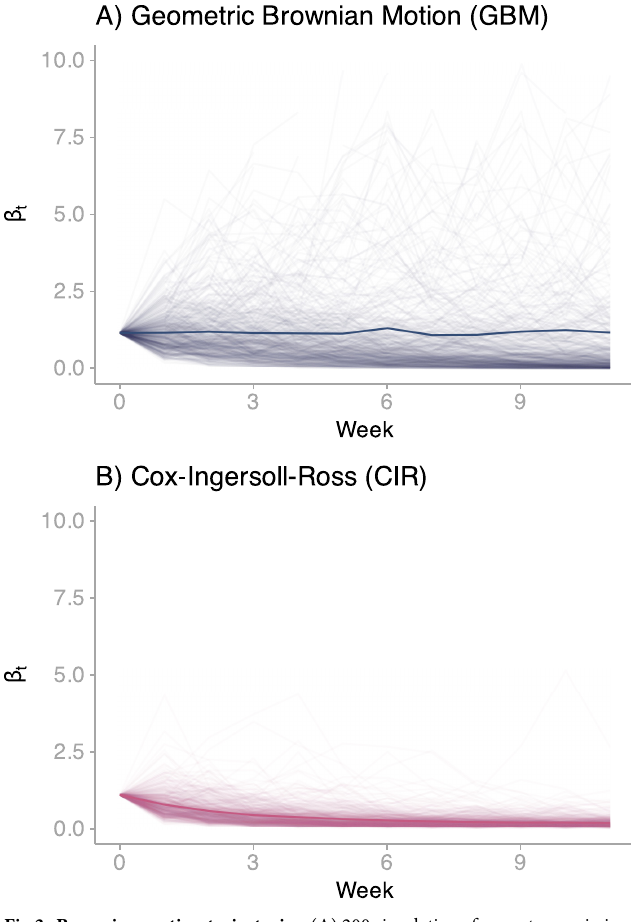
Fig 3. Brownian motion trajectories. (A) 200 simulations from a transmission rate described in terms of Geometric Brownian Motion. We generate these simulations from DGP1’s Maximum Likelihood Estimate (MLE) using the Euler-Maruyama algorithm. The highlighted trend corresponds to the mean trajectory path. (B) 200 simulations from a transmission rate described in terms of the Cox-Ingersoll-Ross model. We generate these simulations from DGP2’s Maximum Likelihood Estimate (MLE) using the Euler-Maruyama algorithm. The highlighted trend corresponds to the mean trajectory path.